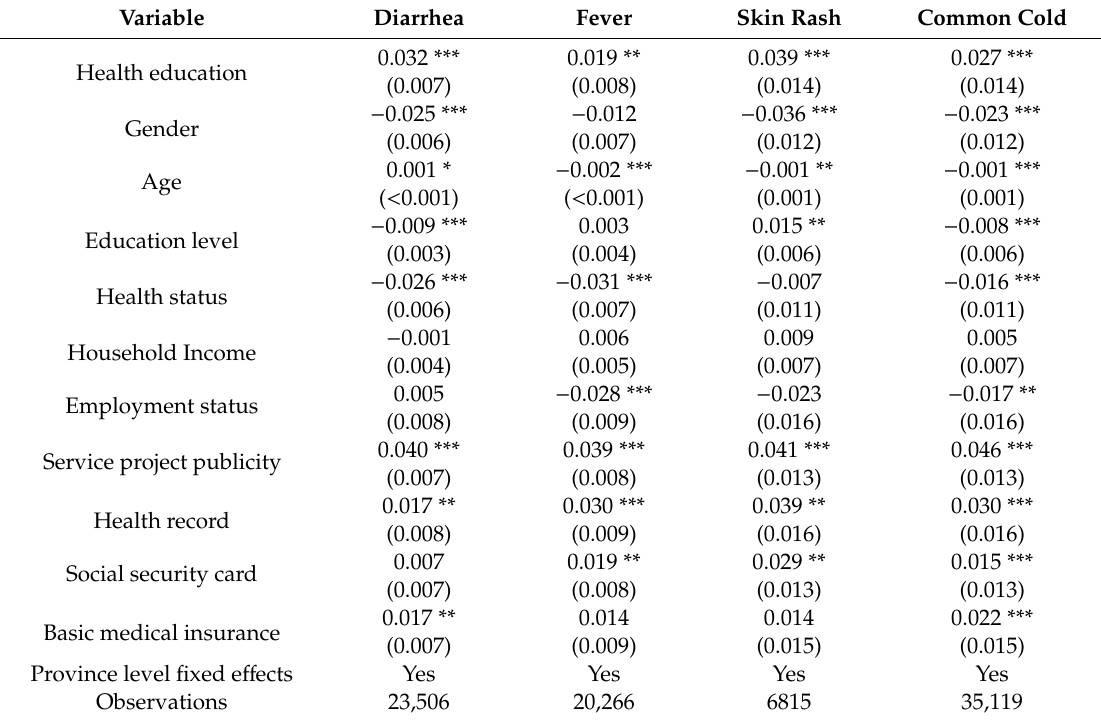
Table 4. E ff ect of health education on healthcare-seeking behavior